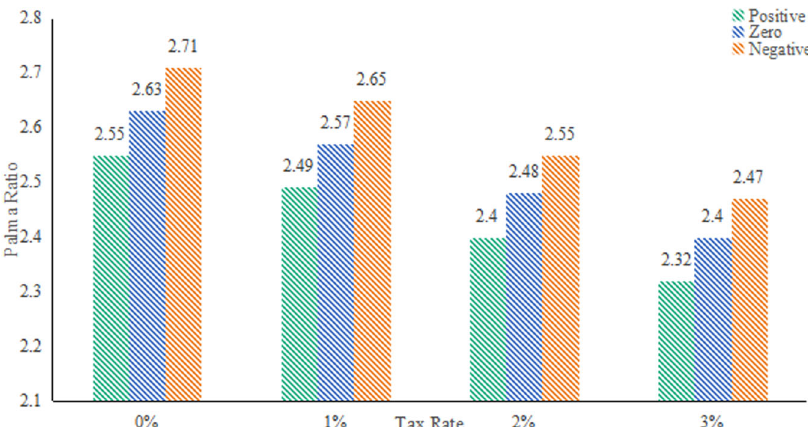
Fig. 1 Impacts of climate damage distribution ( ξ ) on the Palma ratio. Shows impacts of climate damage on the Palma ratio: the legends “ Positive ” , “ Zero ” , and “ Negative ” denote the positive, zero, and negative ξ assumptions.